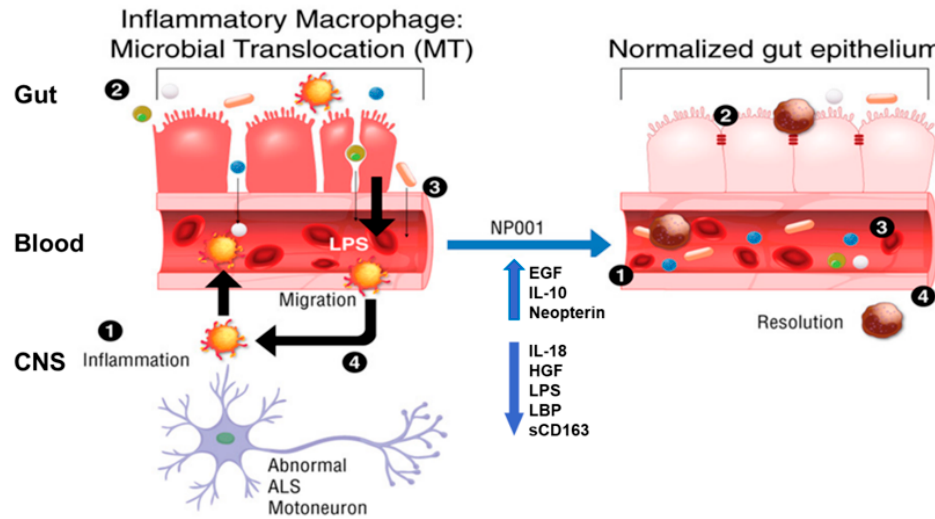
Figure 6. Microbial translocation and resolution with NP001. Abbreviations: CNS, central nervous system; LPS, lipopolysaccharide; EGF, epidermal growth factor; IL-10, interleukin 10; IL-18, inter- leukin 18; HGF, hepatocyte growth factor; LBP, LPS-binding protein; sCD163, soluble CD163. TauCl, taurine chloramine. NFkB, nuclear factor kappa B.